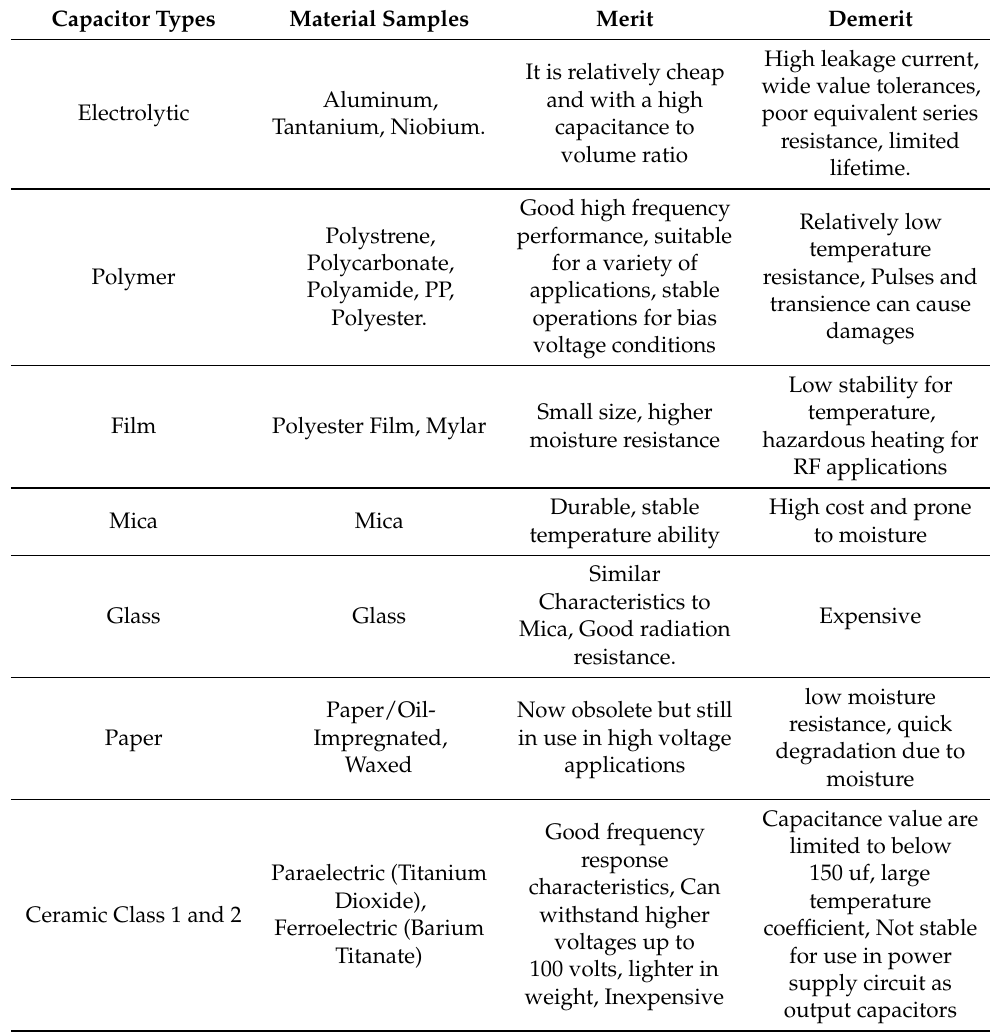
Table 1. Selection Criteria and Comparison among Capacitor